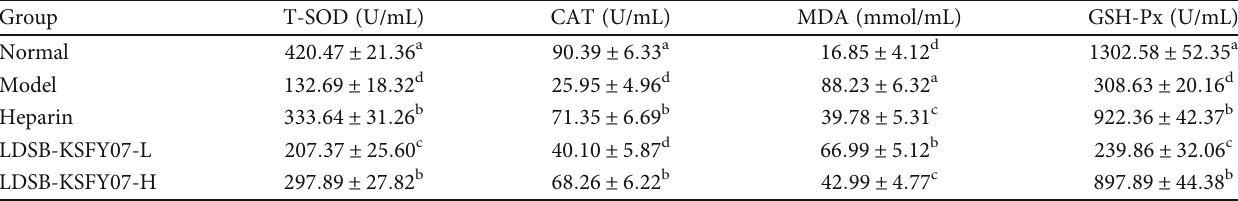
The results have been expressed as mean ± deviation . a – d Mean values with di ff erent letters in the di ff erent column are signi fi cantly di ff erent ( P < 0 : 05 ) according to Duncan ’ s multiple range